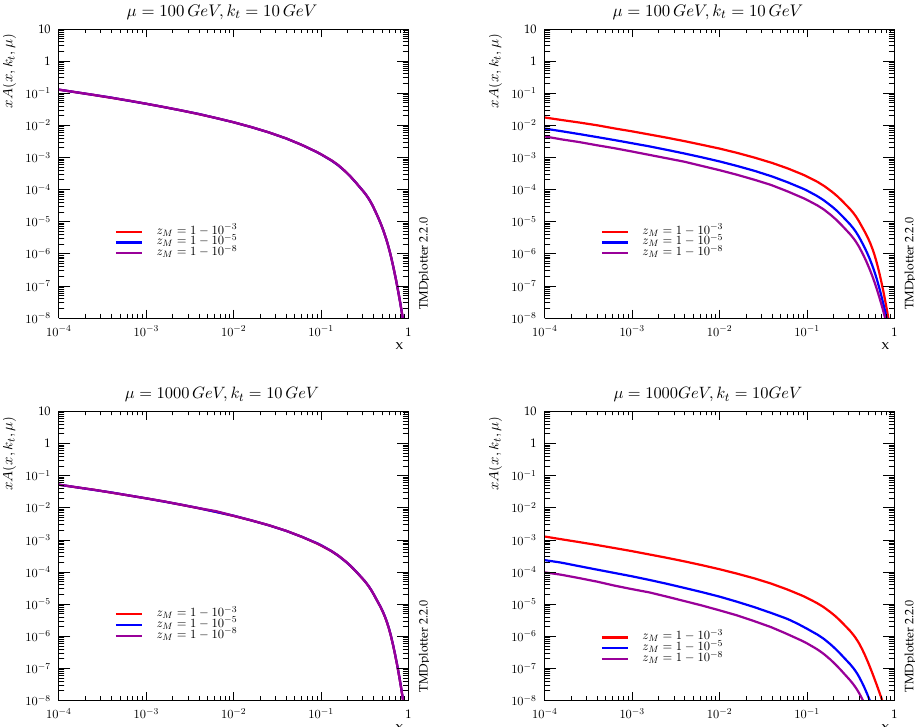
Figure 6 . Transverse momentum gluon distribution versus x at k t = 10 GeV and (cid:22) = 100 GeV (upper row), (cid:22) = 1000 GeV (lower row) for di(cid:11)erent values of the resolution scale parameter z M = 1 10 (cid:0) 3 ; 1 10 (cid:0) 5 ; 1 10 (cid:0) 8 : (left) angular ordering; (right) transverse momentum (cid:0) (cid:0) (cid:0)